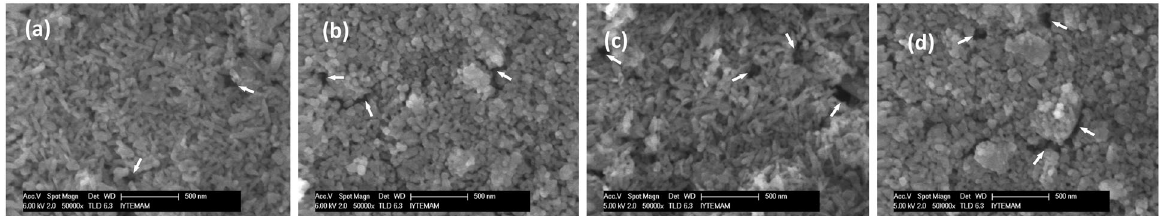
Fig. 7 SEM images of ( a ) the glass/sericin/c-HAp, ( b ) the glass/sericin/m-HAp, ( c ) the glass/ fi broin/c-HAp, ( d ) the glass/ fi broin/m -HAp thin fi lm structures after heat treatment at 560 °C; the arrows indicate some of the hole-like gaps through which sericin and fi broin burnt out.